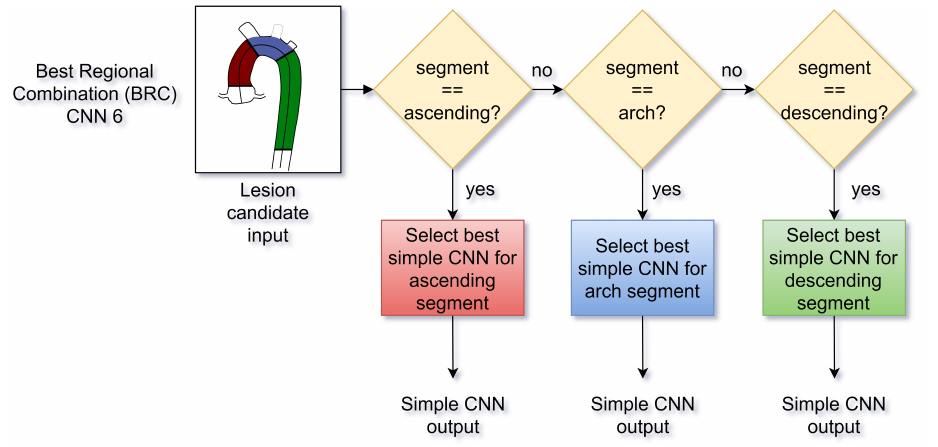
Figure 3. CNN 6: Best Regional Combination